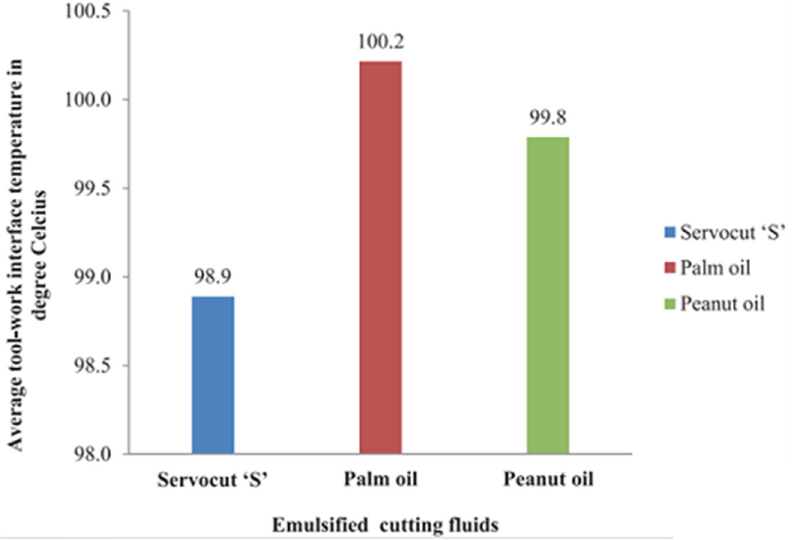
Figure 6. Temperature Variation under Different Cutting fluids [86].